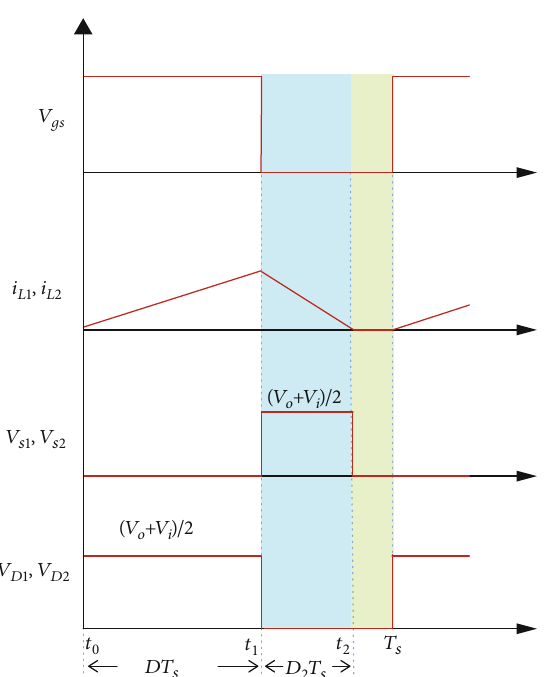
Figure 6: Key waveform in the